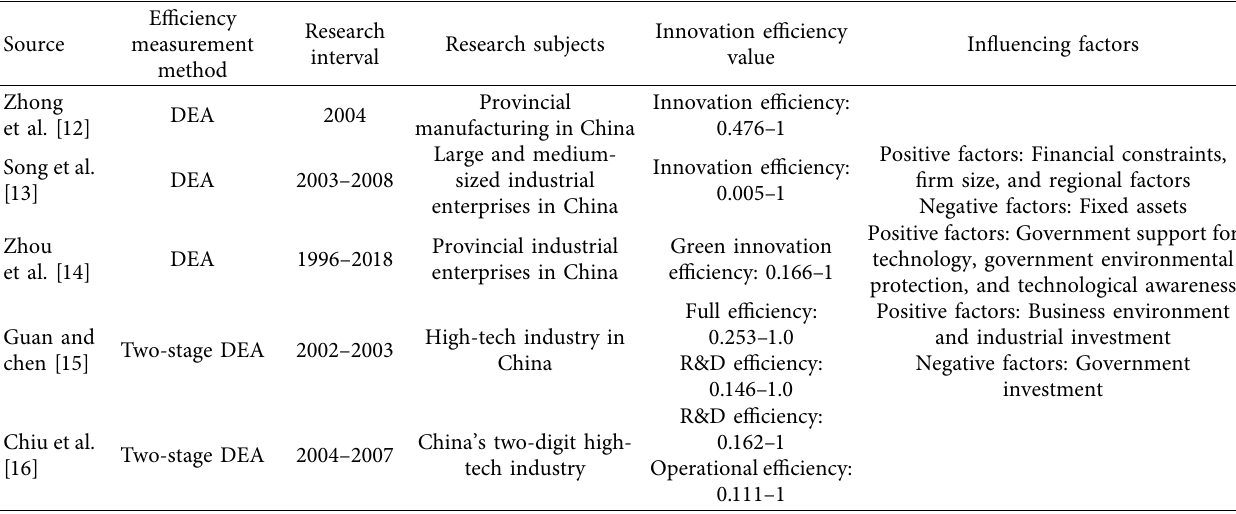
Table 2: Descriptive analysis of the main literature on innovation efciency and performance in China’s industrial